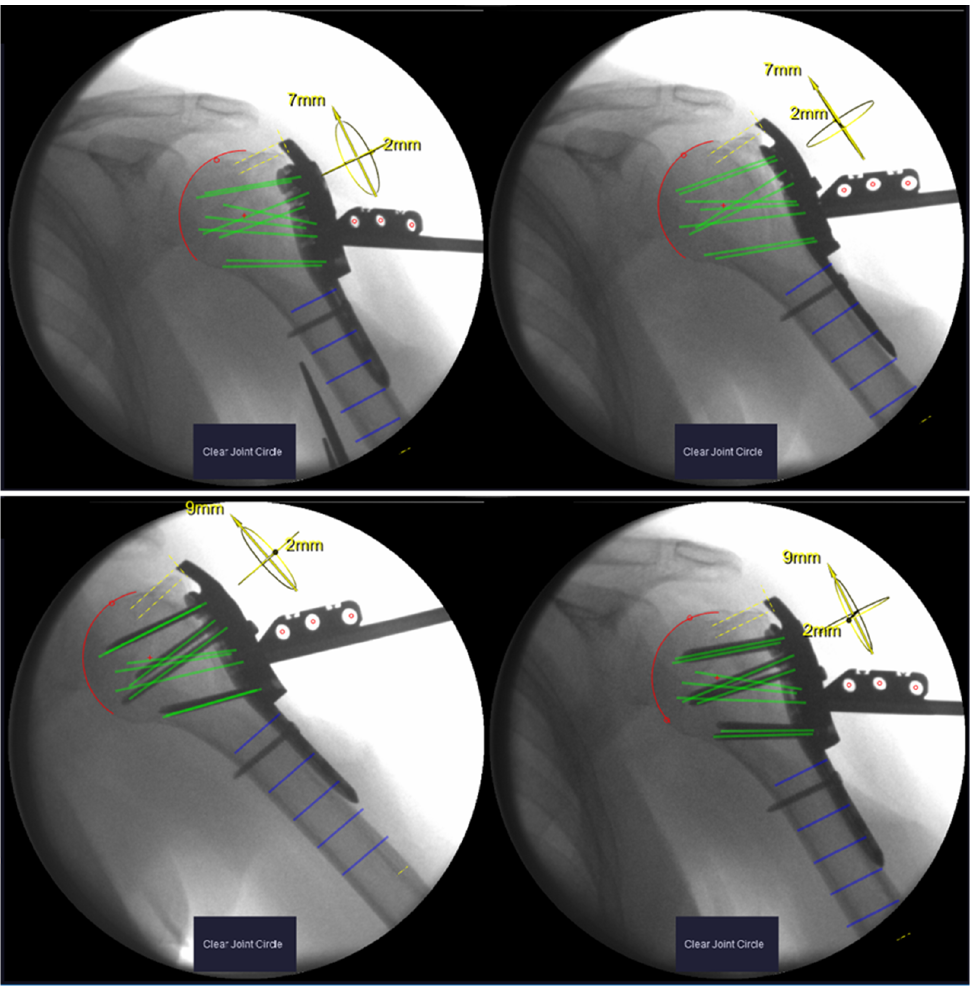
Figure 3. Xin1 software output for an exemplary patient. Top row: image pair before screw insertion. Calculated screw trajectories depicted in green. Segmented humeral head in red. Bottom row: image pair after screw insertion (verification images). Green trajectories coincide with inserted screws.